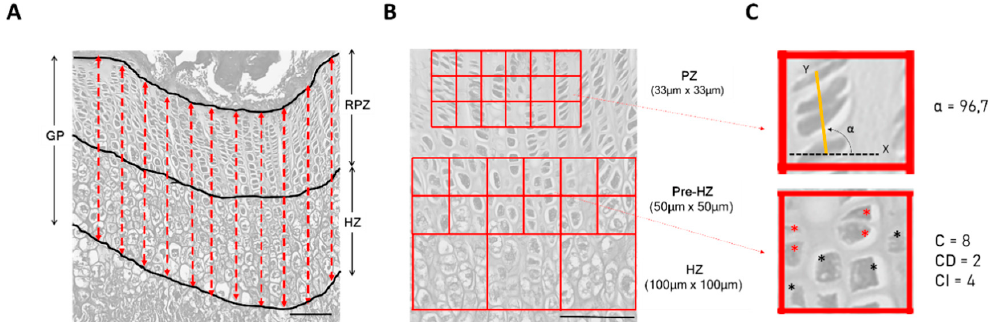
Figure 1. Image processing for quantitative analysis of wild type 1-month-old rat growth plates. ( A ) Evaluation of total growth plate (GP) and zonal thickness (resting andproliferative zone (RPZ); hypertrophic zone (HZ)). 10× magnification; ( B ) Grid used for evaluation of columnar organization per zone, as previously described in [25] (proliferative zone (PZ); pre-hypertrophic zone (Pre-HZ); hypertrophic zone (HZ) 20× magnification. Scale bars = 100 µm; ( C ) Illustration of quantitative description of growth plate columnar organization. The upper panel shows the calculation of α where the axis labeled as Y (yellow line) symbolizes the line that links the geometric centers of the cells that form the column, while the axis labeled as × (dotted black line) represents the transversal axis to the one in the preferential bone growth (corresponding to the ossification front). α represents the column orientation angle. The lower panel illustrates the calculation of parameters cellular density (C), CD, and CI. Asterisks mark the cells quantitated within the field; columnar cells are marked in red and isolated cells are marked in black.